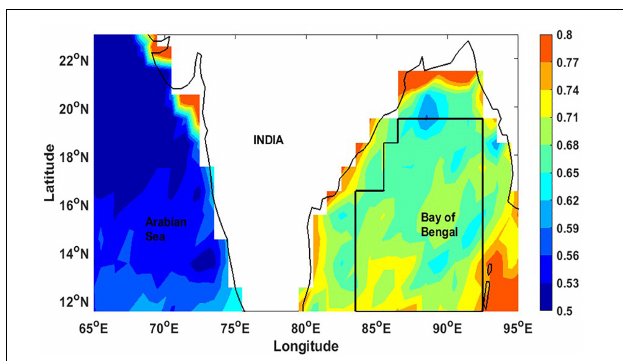
FIGURE 1 | The monthly mean Angstrom Exponent (AE) climatology over the oceanic regions around India during the period 2003–2018 for